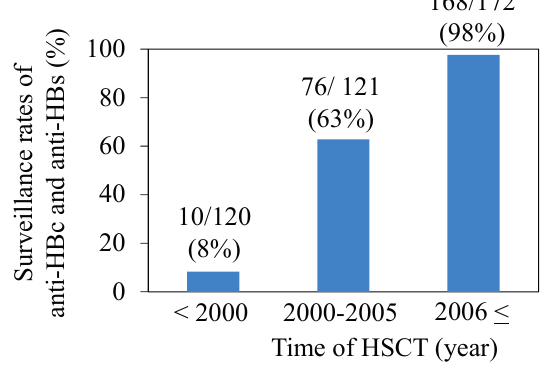
Figure 1. Surveillance rates of antibodies to hepatitis B core antigen (anti-HBc) and to hepatitis B surface antigen (anti-HBs) according to the time of hematopoietic stem cell transplantation